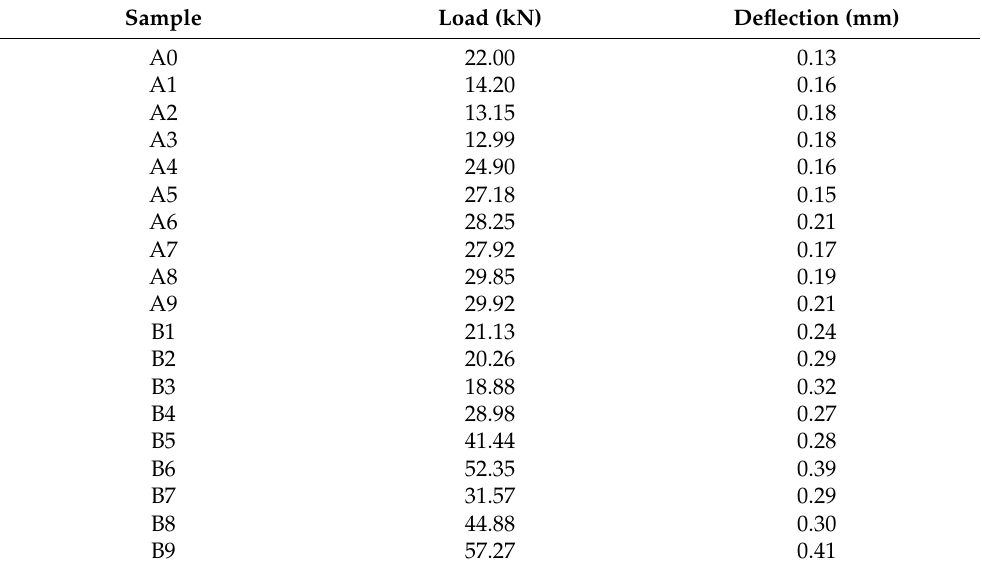
Table 14. Comparison between max load and deflection results of the nineteen tested specimens for patching